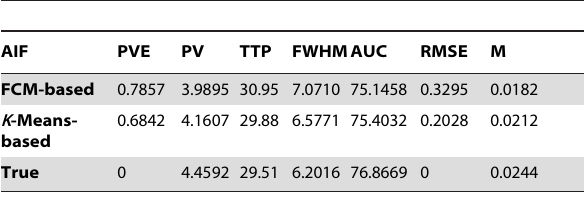
Table 1. Comparison of AIFs based on the two clustering methods and the true